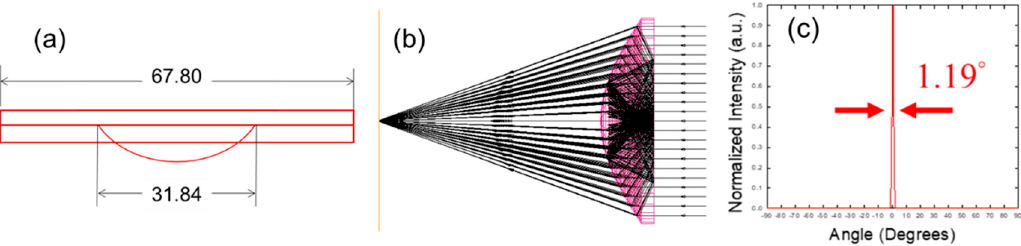
Figure 9. ( a ) Structure of the modified cover lens; ( b ) ray fans in the simulation; and ( c ) divergence angle of the spot light.